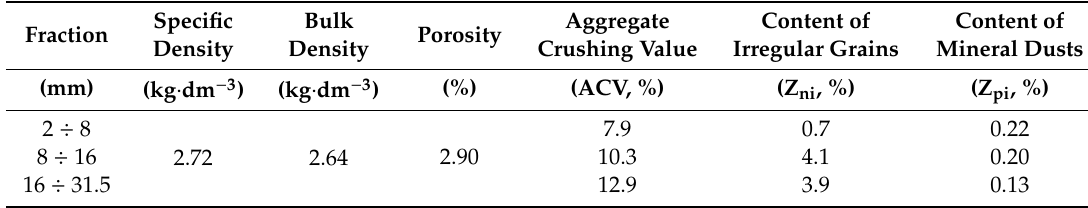
Table 2. Tests results of gravel properties.